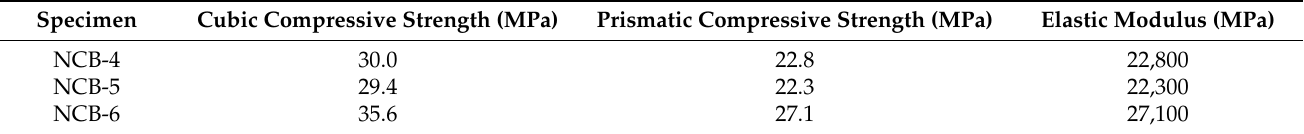
Table 2. Material properties of concrete in NCB-4, NCB-5 and